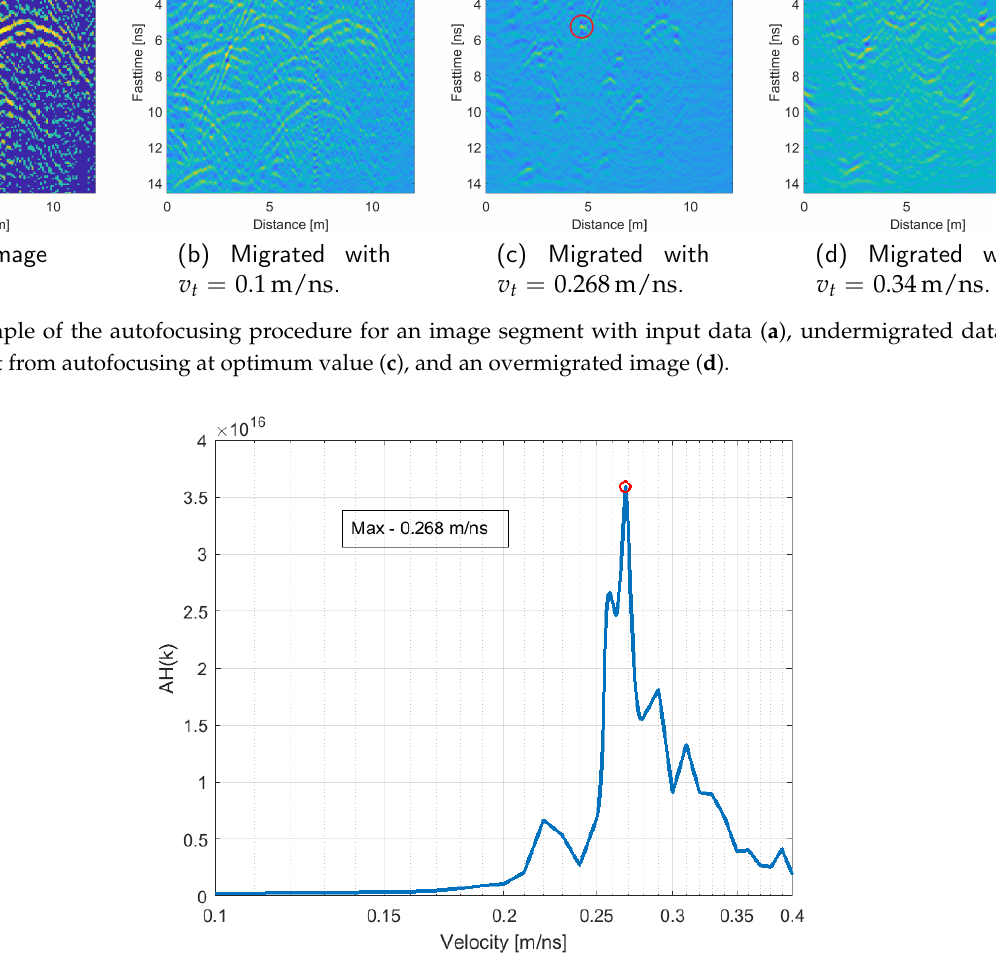
Figure 4. Example autofocusing metric from Equation